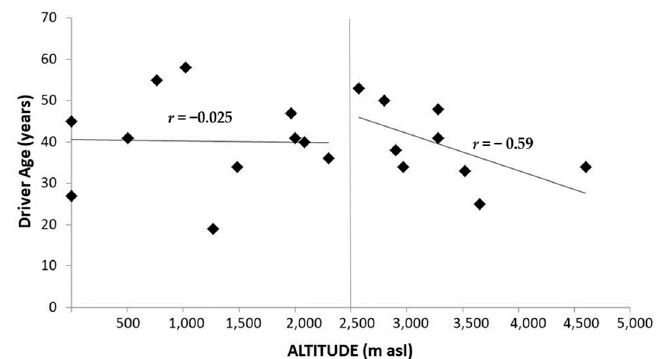
Figure 4. Fatal road traffic accidents in Chilean mining ( n = 18) and ALMA Observatory ( n = 2) between the years 2005 and 2017, comparing the age of the deceased driver in terms of the altitude at which the accident occurred. The younger the subjects are, they appear to be more susceptible to suffer fatal accidents at altitudes from 2500 m ACL upward ( r = −0.59) (De Gregorio, N (Faculty of Medicine, University of Chile. Santiago, Chile). Unpublished results. 2020). Notice that subjects younger and older than 40 years appear rather evenly distributed on the right-hand side of the graph.